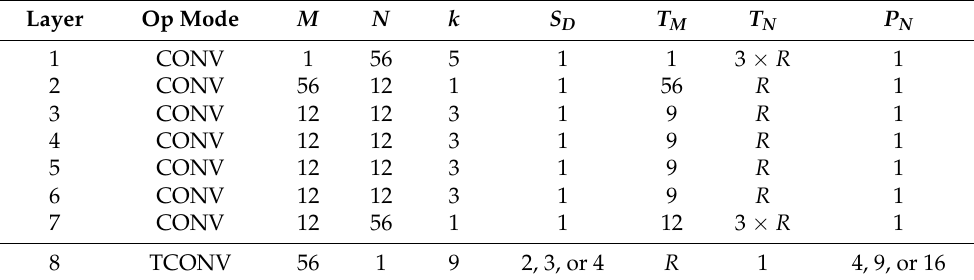
Table 1. The run-time configurations of the novel hardware accelerator related to the